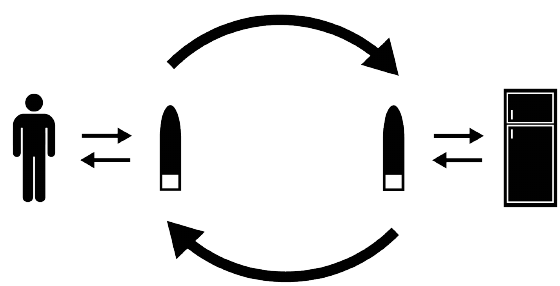
Figure 2: The figure shows how the second human being can be substituted by a common object with a computer embedded into it like a fridge. A human being can be in relation to an object like a fridge through the use of teledildos which translate the input provided by it in motions and tactile